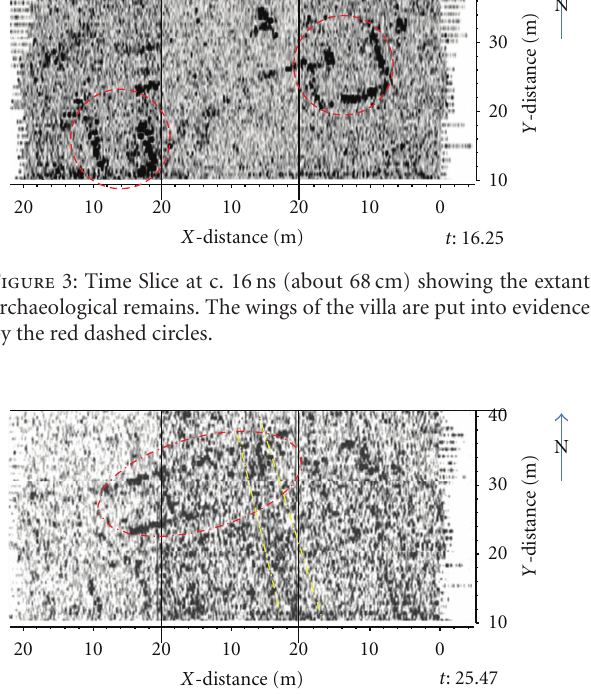
Figure 4: Time slice at c. 25ns (about 106 cm) showing the extant archaeological remains. The corridor between the wings of the villa is put into evidence by the red dashed tilted ellipse, and the ditch is put into evidence by the yellow dashed